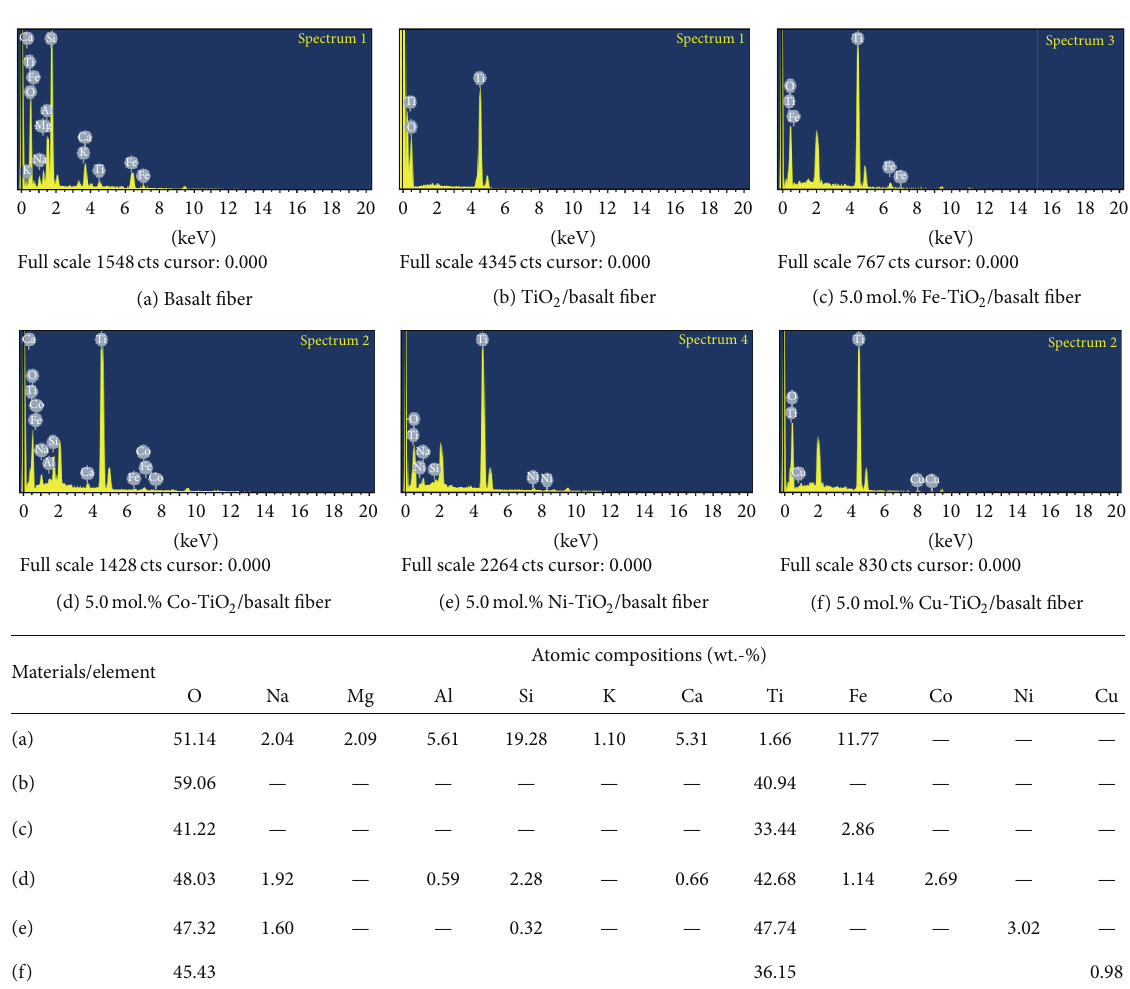
Figure 8: Energy-dispersive X-ray spectra of the surfaces of the pure basalt fiber and 5.0 mol.% M-TiO 2 /basalt fiber films and the atomic